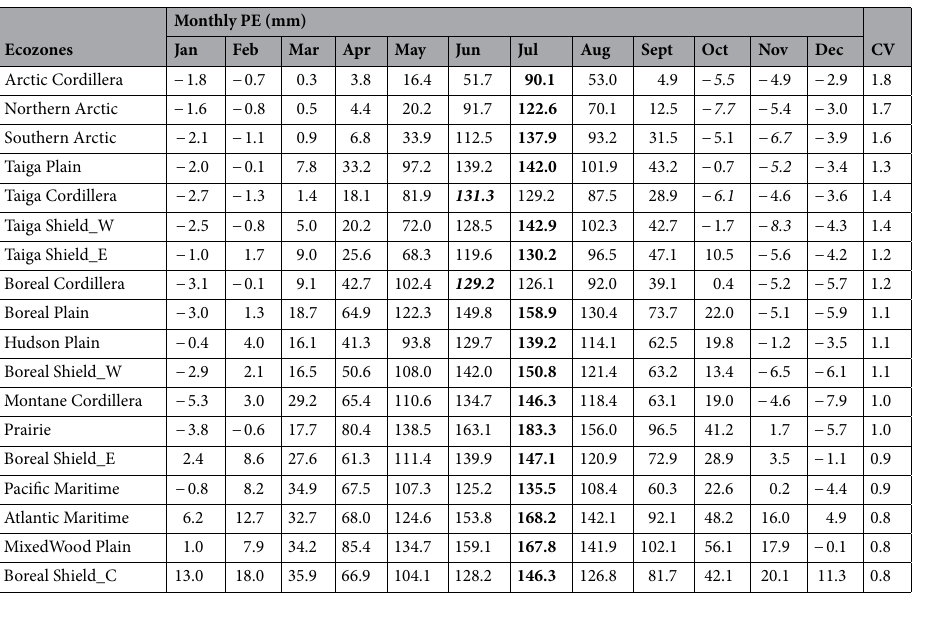
Table 2. The seasonal changes in potential evaporation (PE) over the 18 Ecozones, shown by monthly PE and the coefficient of variation (CV) (Bold font highlights the maximum monthly